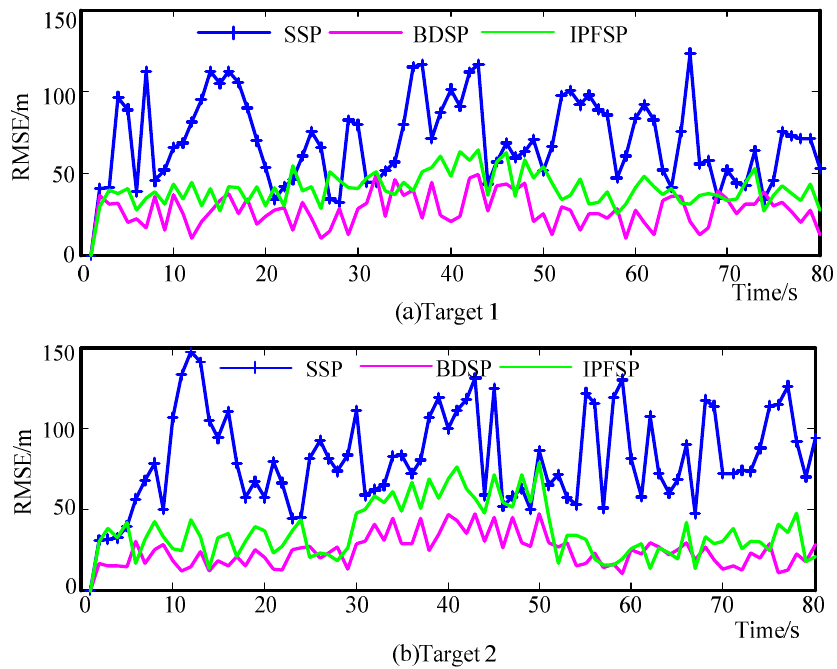
Figure 21. RMSE of target position under different scheduling policies. ( a ) Target 1; ( b ) Target 2.